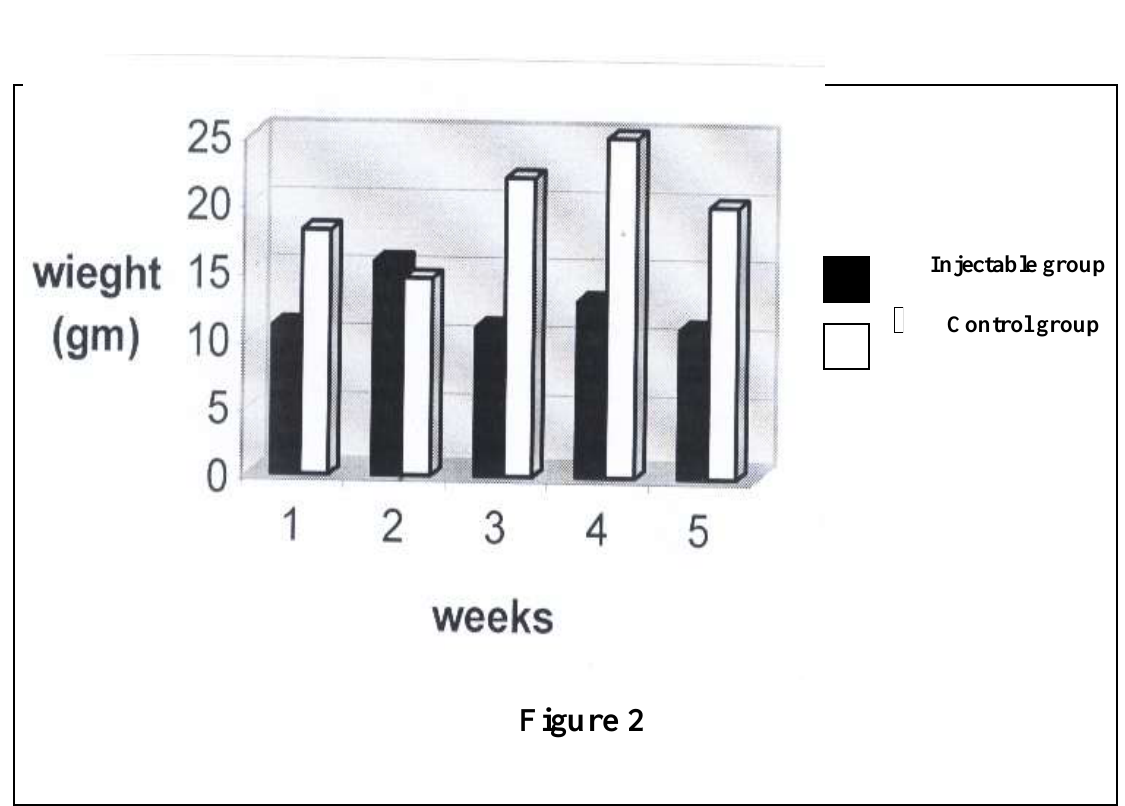
CClliinniiccaall FFiinnddiinnggss:: TThhee ttrreeaatteedd ggrroouuppss sshhoowweedd aaggggrreessssiivvee bbeehhaavviioouurr ,, aass iinnjjeecctteedd mmiiccee ssttaarrtteedd ffiigghhttiinngg wwiitthh eeaacchh ootthheerr ddiirreeccttllyy aafftteerr iinnjjeeccttiioonn tthheenn hhoouurrss llaatteerr ssttaarrtteedd ttoo bbee qquuiittee ,, tthheerree wwaass nnoo ddiiffffeerreenncceess bbeettwweeeenn mmaalleess aanndd ffeemmaalleess iinn tthhee aappppeeaarraannccee ooff cclliinniiccaall ssiiggnnss ,, aallll ttrreeaatteedd ggrroouuppss sshhoowweedd ttoo bbee aaccttiivvee hheeaalltthhyy wwiitthh iinnccrreeaassee ooff bbooddyy wweeiigghhtt ,, eessppeecciiaallllyy tthhrreeee wweeeekkss aafftteerr iinnjjeeccttiioonn ,, wwhhiillee mmiiccee ssttaarrtteedd ttoo ssuuffffeerr ffrroomm ssiiggnnss ooff hhyyppooggllyyccaaeemmiicc ssppeecciiaallllyy GGrroouupp AA ,, BB ((FFiigg..11)) ..TThheeyy wweerree nnoott aabbllee ttoo mmoovvee ,, PPoooorr ccoonnddiittiioonn wwiitthh ggeenneerraallllyy wweeaakk mmuussccllee aanndd bboonneess ,, ttrreemmoorrss ,, ggeenneerraall ccoonnvvuullssiioonn ,,iinn aaddddiittiioonn ttoo nneerrvvoouussnneessss aanndd iirrrriittaabbiilliittyy,, rraappiidd bbrreeaatthh aanndd bbrraaddyyccaarrddiiaa aanndd aarrcchh bbaacckk ,, tthheenn ccoonnvvuullssiioonn ooff aallll oovveerr tthhee bbooddyy ( ( F F i i g g . . 2 2 ) ) , , C C o o m m a a a a n n d d d d e e a a t t h h n n e e a a r r l l y y 1 1 0 0 0 0 % % i i n n IInntteerrmmeeddiiaattee ddoossee ggrroouupp )) wwhhiicchh tthheeyy ssuuffffeerreedd ffrroomm hhyyppooggllyyccaaeemmiicc aattttaacckkss ..OOtthheerr cclliinniiccaall ssiiggnnss wweerree ppoooorr ccoonnddiittiioonn ,, tthheeyy sshhoowweedd ppiillooeerreeaaccttiioonn ,, llaammeenneessss iinn ssoommee ooff tthhee lleeggss ,, ccoonnttiinnuuoouuss ttrreemmoorr aanndd rreedduuccee ffoooodd ccoonnssuummppttiioonn iinn aallll iinnjjeecctteedd ggrroouuppss,, ffuurrtthheerr mmoorree ,, tthheerree wwaass lloossss ooff eellaassttiicciittyy ooff sskkiinn aanndd lliippooddyyssttrroopphhyy ,,((FFiigg 33)),, iinn aaddddiittiioonn ttoo tthhiicckkeenneedd sskkiinn aanndd uullcceerraattiioonn.. WWhhiillee ggrroouupp BB cclliinniiccaallllyy ssiimmiillaarr ttoo ootthheerr ttrreeaatteedd ggrroouuppss bbuutt mmoorree wwiitthh 110000 %% ddeeaatthh rraattee aafftteerr hhyyppooggllyyccaaeemmiicc aattttaacckkss ffoorr bbootthh mmaalleess aanndd ffeemmaalleess ,,wwiitthh cclleeaarr sskkiinn lleessiioonnss cchhaarraacctteerriizzeedd bbyy aappppeeaarraannccee ooff ppooxx--lliikkee ppuussttuulleess oonn tthhee aabbddoommeenn aanndd tthhiigghh rreeggiioonn ,, ggeenniittaall aanndd eeyyee lleessiioonnss ((iinn ssoommee ccaasseess